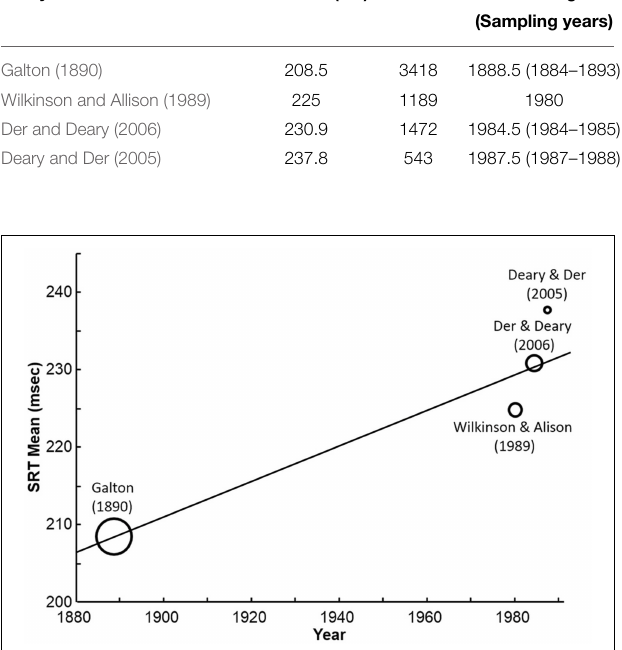
FIGURE 1 | Secular SRT slowing across four large, representative studies from the UK spanning a century. Bubble-size is proportional to sample size. Combined N = 6622